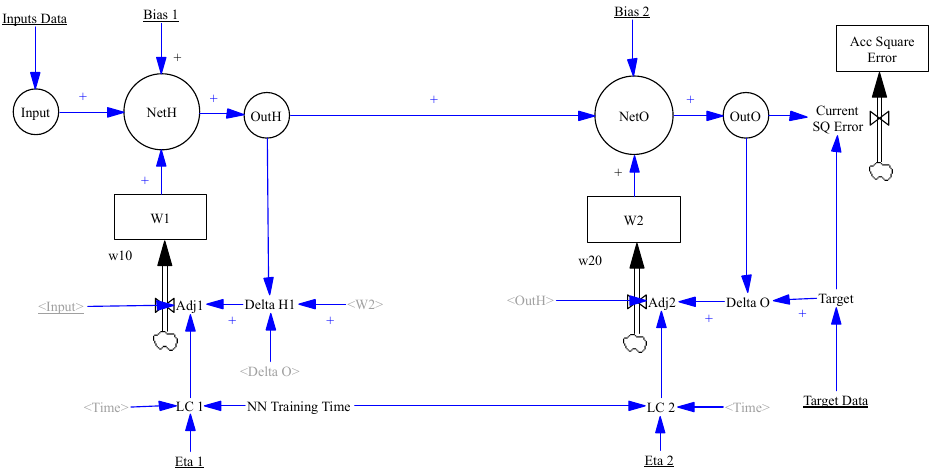
Figure 5. Stock and Flow Diagram (SFD) of the ANN dynamic simulation model with backpropagation for power consumption prediction.